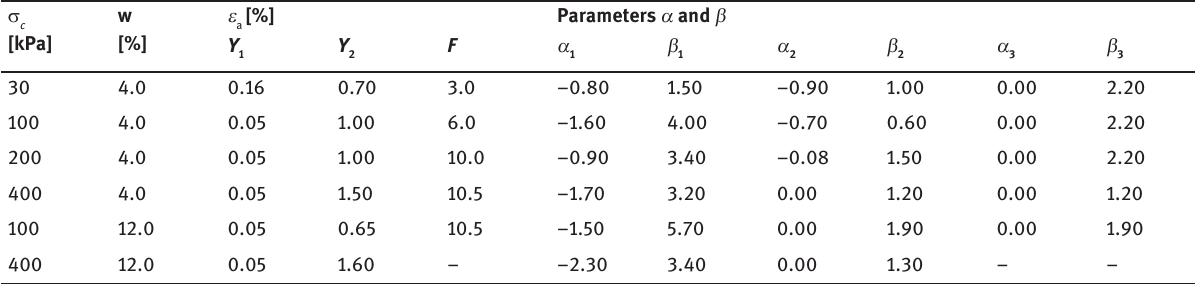
Table 4: Characteristic points and stress–dilatancy parameters for fouled railway